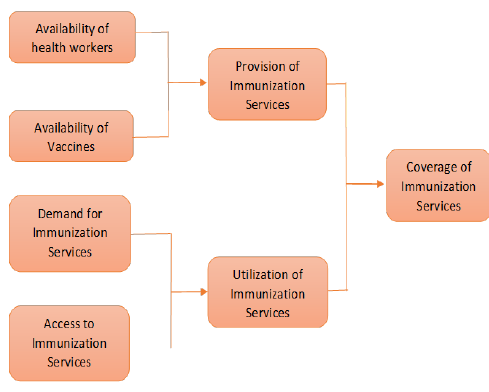
Fig. 1. Framework for the effects of health system components on coverage of immunization